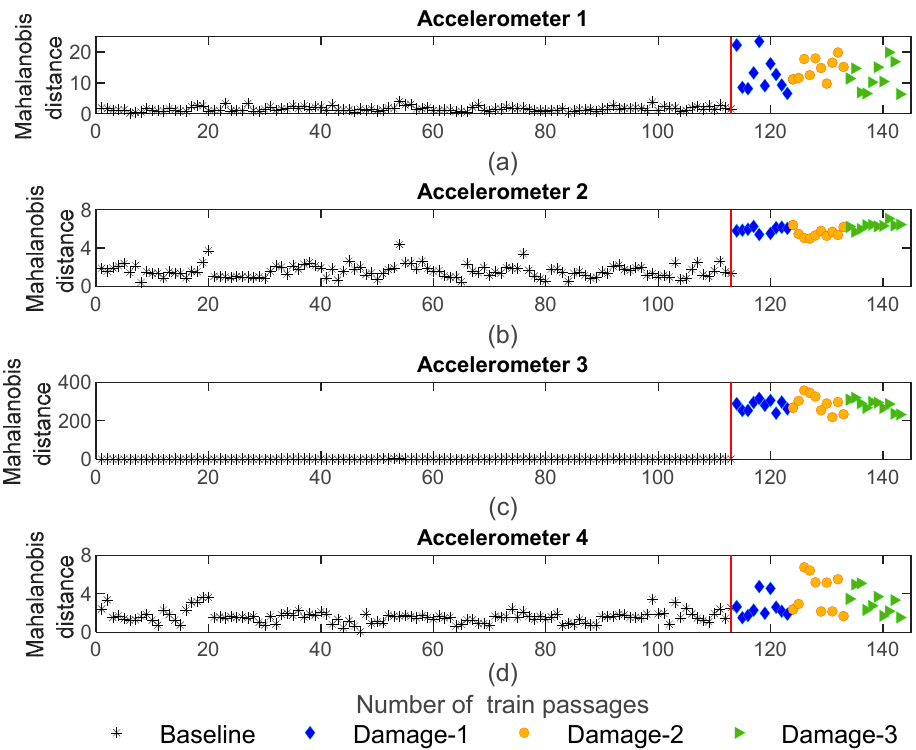
Figure 19. PCA—data fusion for all 143 baseline and damage scenarios: ( a ) MD for accelerometer 1, ( b ) MD for accelerometer 2, ( c ) MD for accelerometer 3, ( d ) MD for accelerometer 4.